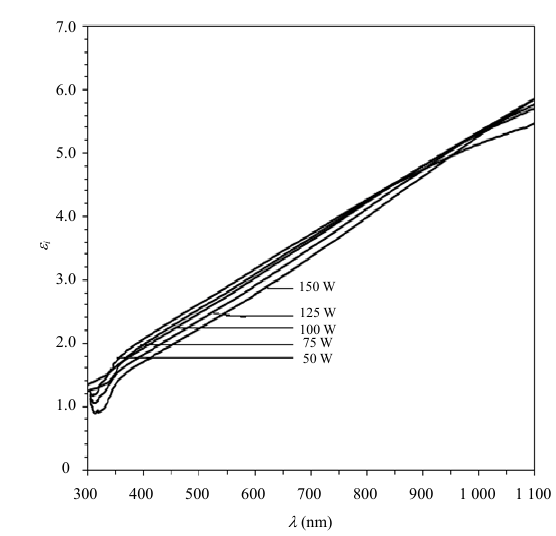
Fig. 8 Dielectric constant imaginary as a function of wavelength for (Ti6Al4V) thin film at different working RF powers.